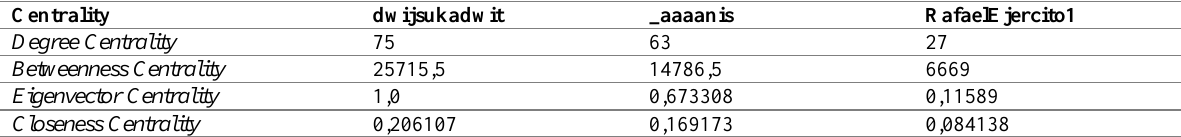
Table 2: Centrality Properties for Key Players